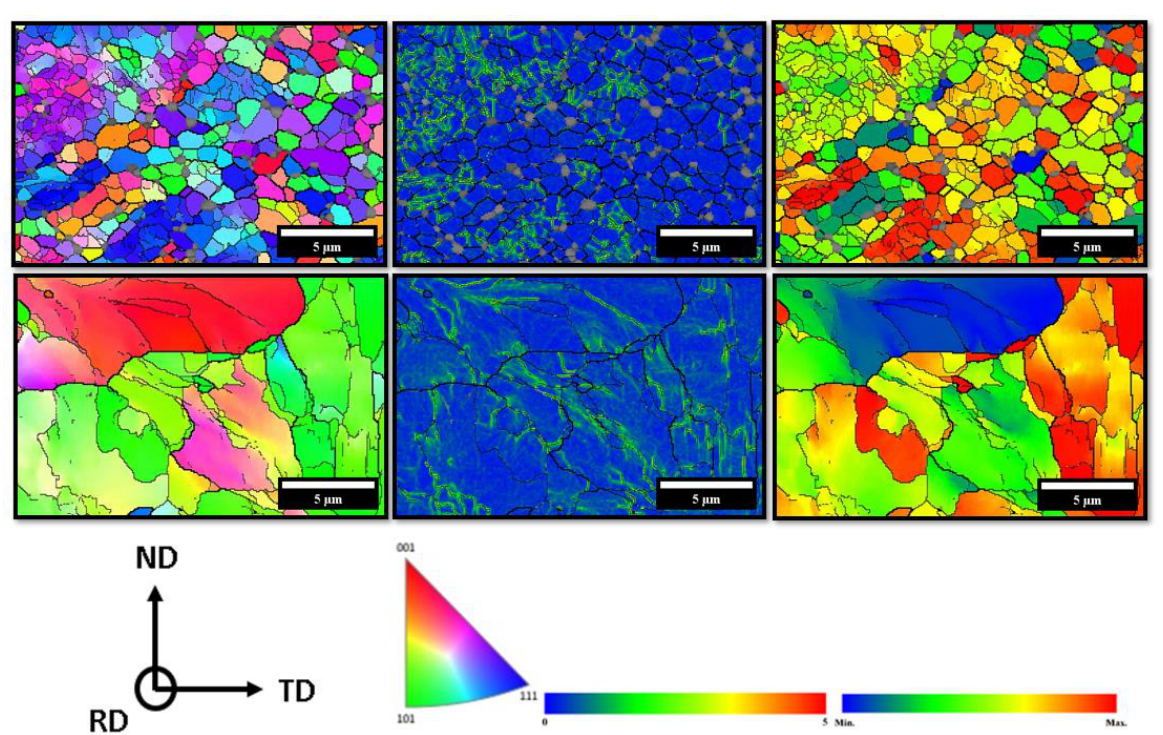
Figure 10. Orientation maps (OIM) of heat-treated samples in the normal direction (ND), third-order kernel average misorientation (KAM) map, and Taylor factor map.